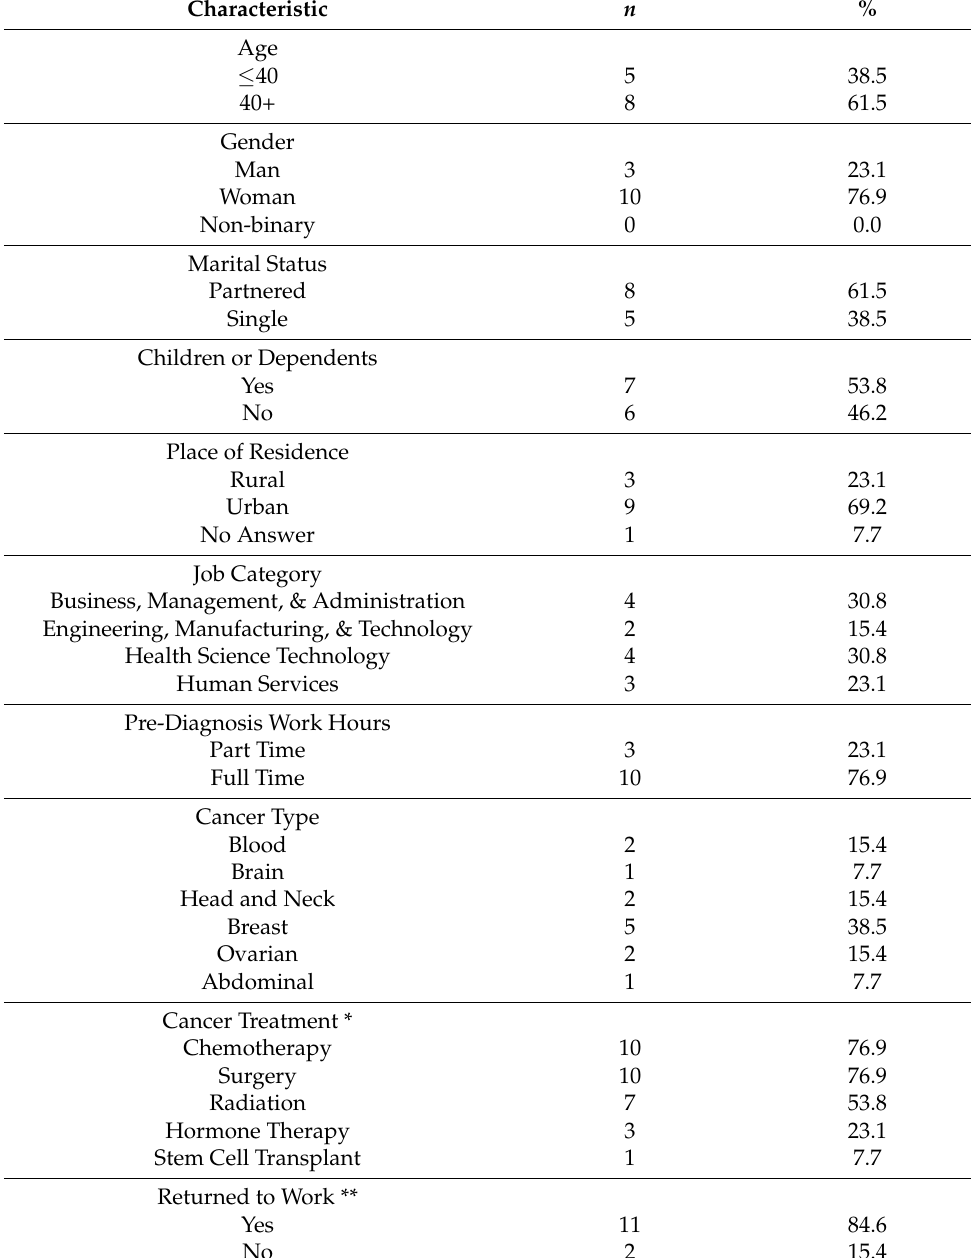
Table 1. Participant characteristics ( N =